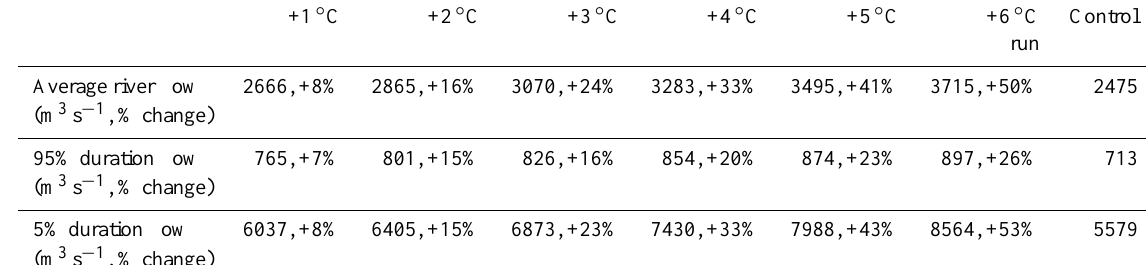
Table 4. Hydrological modelling results using the same GCM (HadCM3) and different mean global temperature increase scenarios. Control run was calculated using 30 years, from 2040 to 2069.